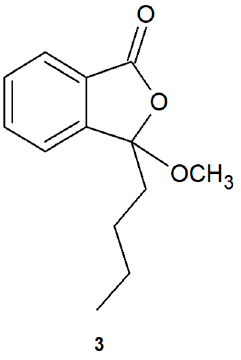
Figure 7. Product (3-butyl-3-methoxyphthalide) ( 3 ) of the esterification of the biotransformation mixture of Aspergillus candidus AM